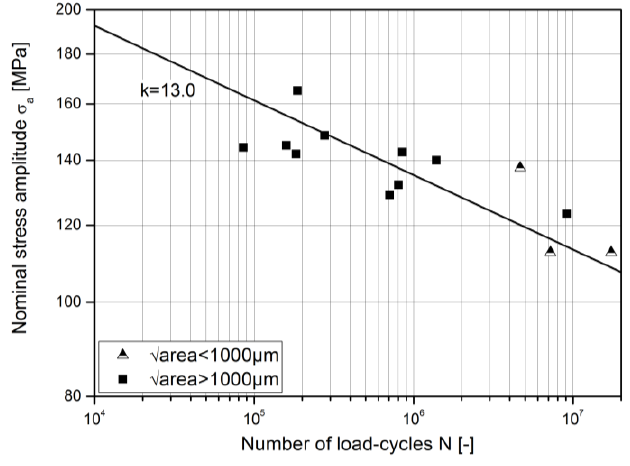
Figure 5. Fatigue test results and statistically evaluated S/N-curve for P S = 50%.